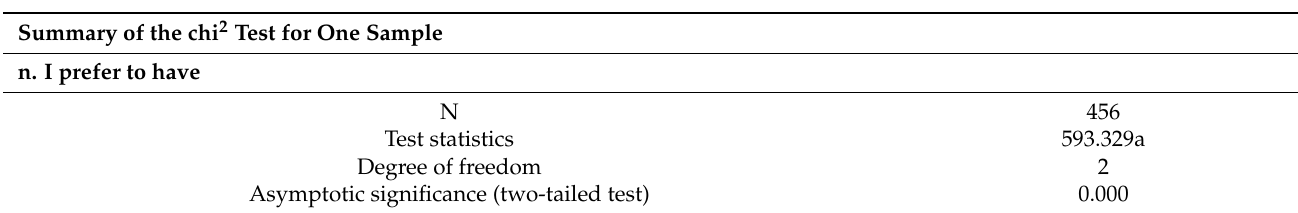
Summary of the chi 2 Test for One